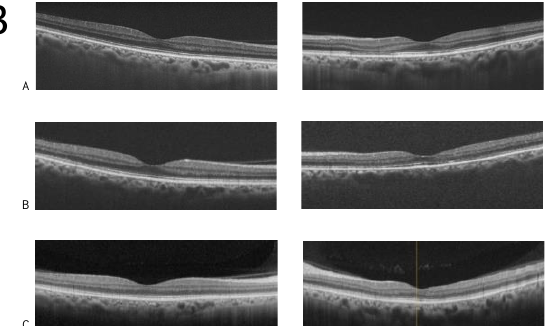
Figure 3. ( 1 ) Humphrey visual field 30–2 map and total deviation map ( A ). baseline; ( B ) 6 months after Tacrolimus discontinuation; ( C ) 3 years after Tacrolimus discontinuation. Progressive resolution of the left eye central scotoma is evident; ( 2 ) Optical coherence tomography (OCT) Thickness Maps ( A ) baseline, ( B ) 6 months after Tacrolimus discontinuation, ( C ) 3 years after Tacrolimus discontinu- ation. Macular thickness progressively reduced in the left eye more than in the right eye; ( 3 ) OCT retinal segmentation analysis of both eyes ( A ) baseline, ( B ) 6 months after Tacrolimus discontinuation, ( C ) 3 years after Tacrolimus discontinuation. The retina layers are preserved in the right eye and thinning of the outer nuclear layer is evident in the left